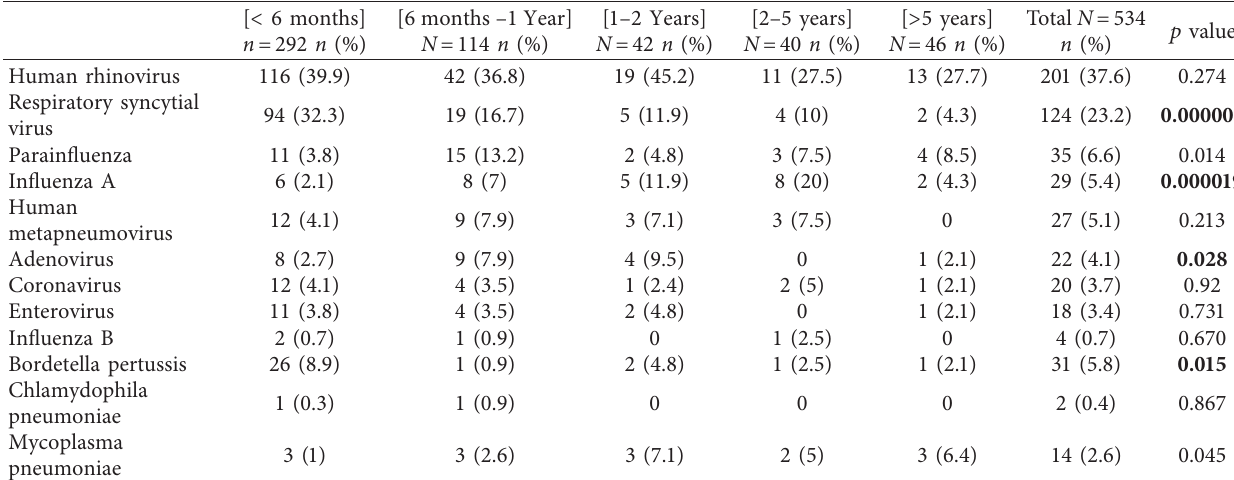
Table 3: Distribution of respiratory pathogens in each age